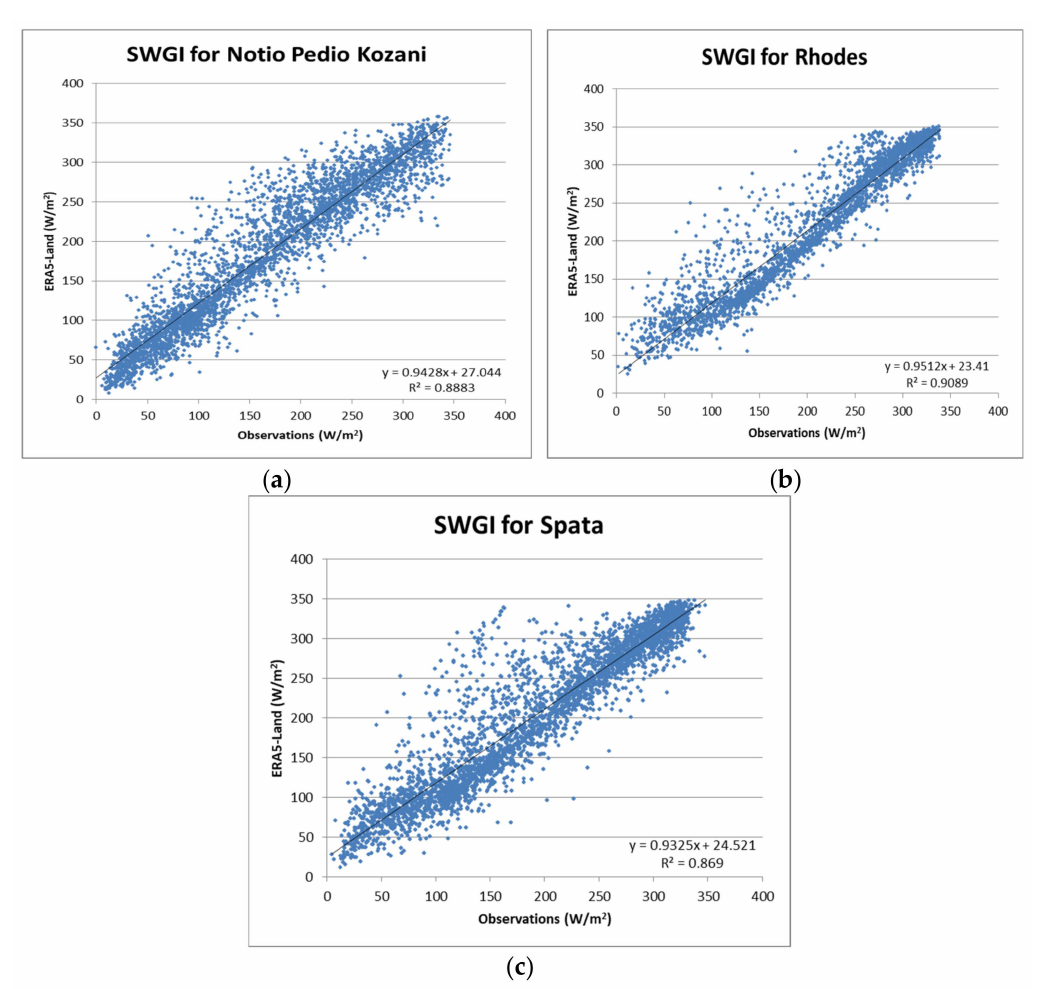
Figure 7. Scatter plots for the entire period of validation at the points of Notio Pedio Kozani ( a ), Rhodes ( b ) and Spata ( c ).